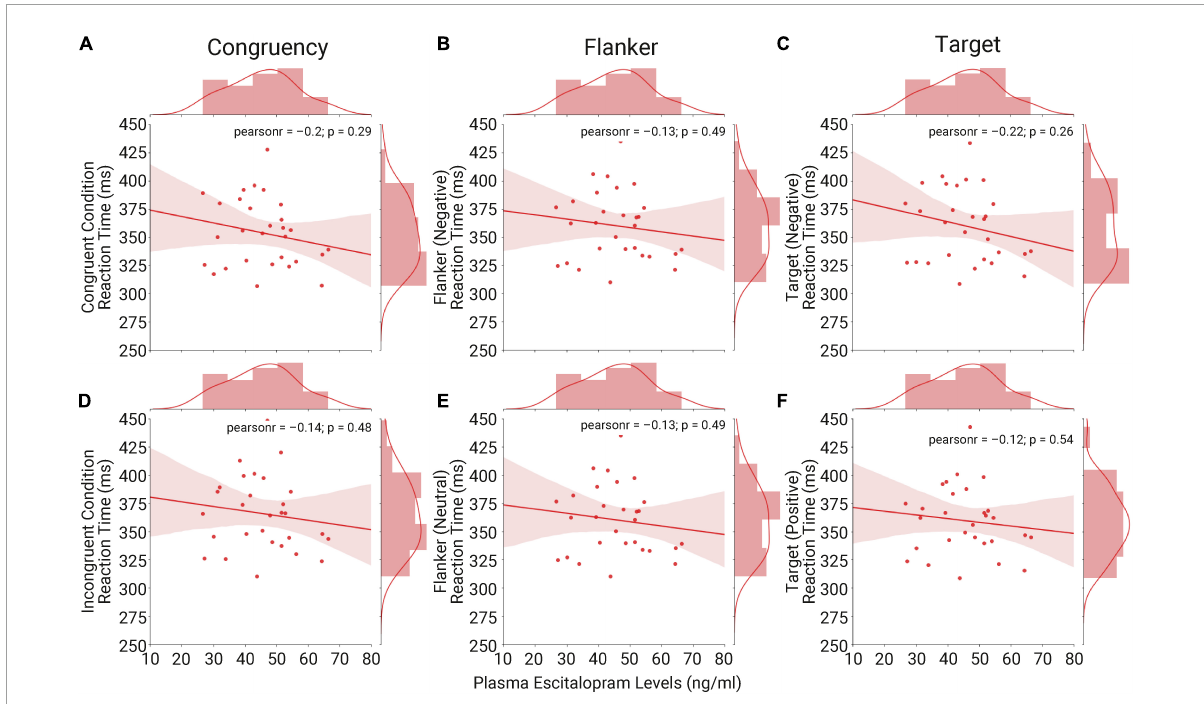
FIGURE4 Correlation analyses at day seven of escitalopram intake for each task condition: We assessed a potential correlation between peripheral measures of plasma escitalopram and behavioral performance in each task condition category with a bivariate Pearson’s correlation. Results for the congruency condition [left column (A,D) ], flanker condition [middle column (B,E) ] and target condition [right column (C,F) ] show no evidence of a correlation. Results considered significant at a Bonferroni-corrected p -value of < 0.008 due to multiple testing.